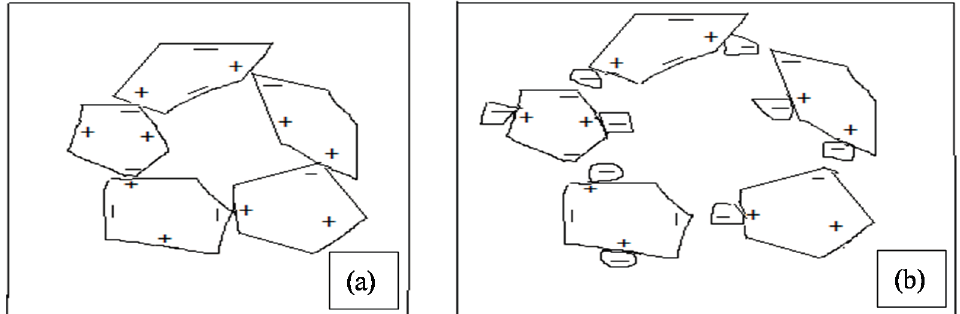
Figure 5. Diagrammatic representation of treated POFA particles adsorbs on and disperses cement particles; ( a ) Flocculation caused by oppositely ( b ) Treated POFA particles adsorb on cement charged surfaces of cement particles Surfaces of cement particles resulting in dispersion opposite charges of